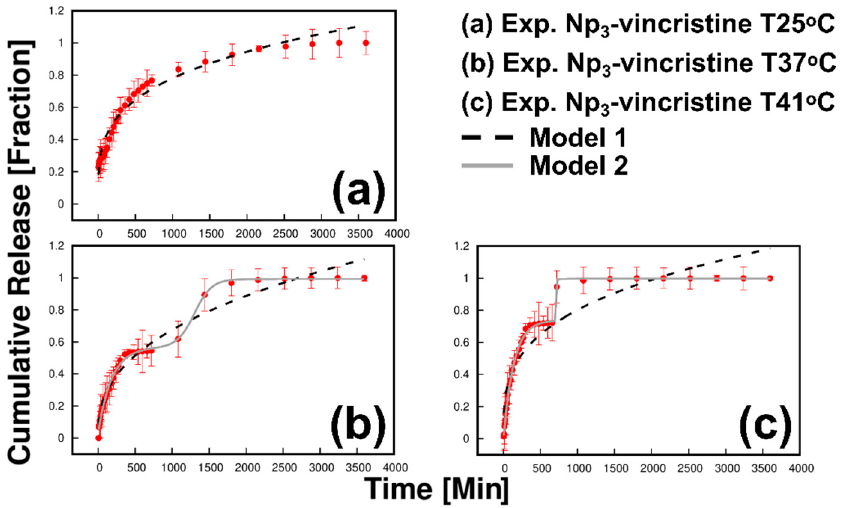
Figure 8. Correlation of mathematical models 1 and 2 of the release fraction of vincristine of the Np 3 ‐ vincristine sample at different temperatures ( a ) 25 °C; ( b ) 37 °C and ( c ) 41 °C. Experimental data at 37 °C shows R 2 > 0.996 (Table 2) and R 2 < 0.978 (Table 1) for Table 2. Parameters of model 2, the two-stage model